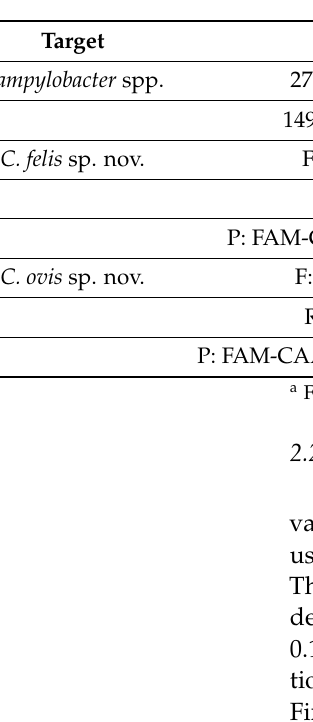
Table 1. Primers and probes used in this